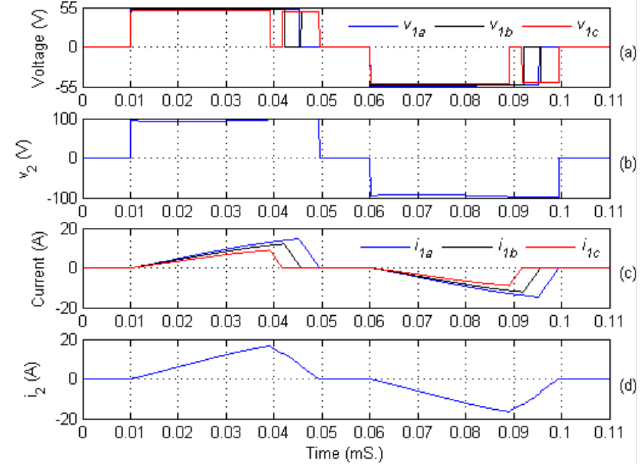
Figure 8. High frequency transformer input winding voltages and currents. ( a ) Transformer input winding voltage, ( b ) transformer output winding voltage, ( c ) transformer input winding current, ( d ) transformer output winding current.